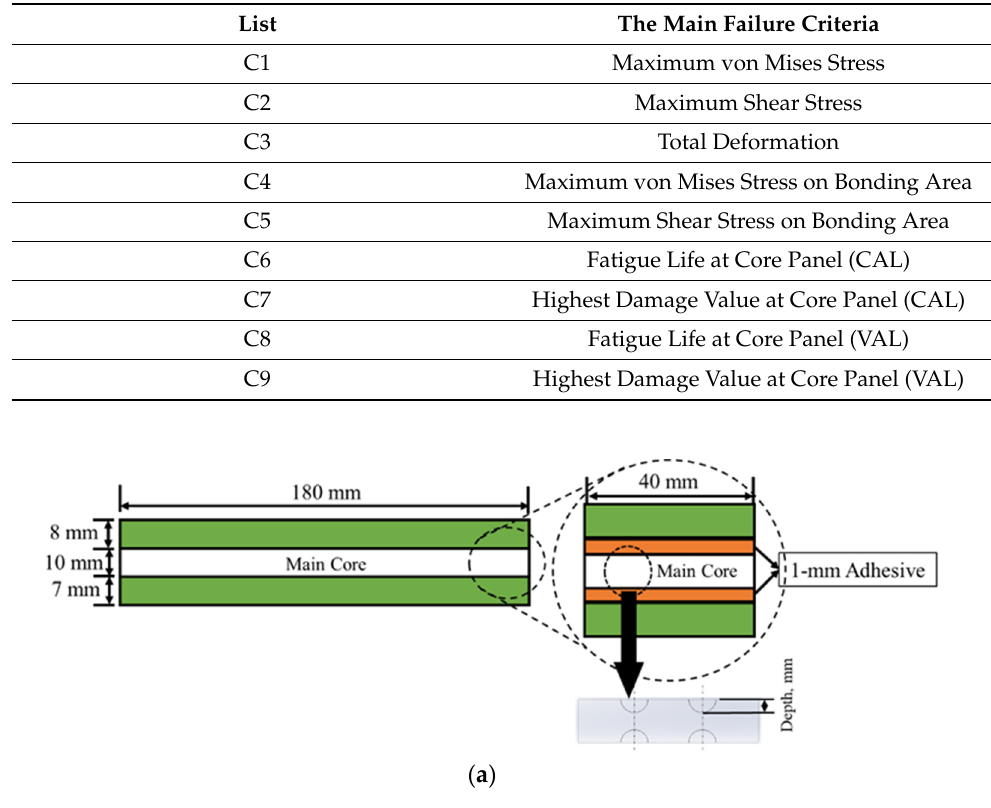
Table 1. The nine main failure criteria, segregated from the simulation results.